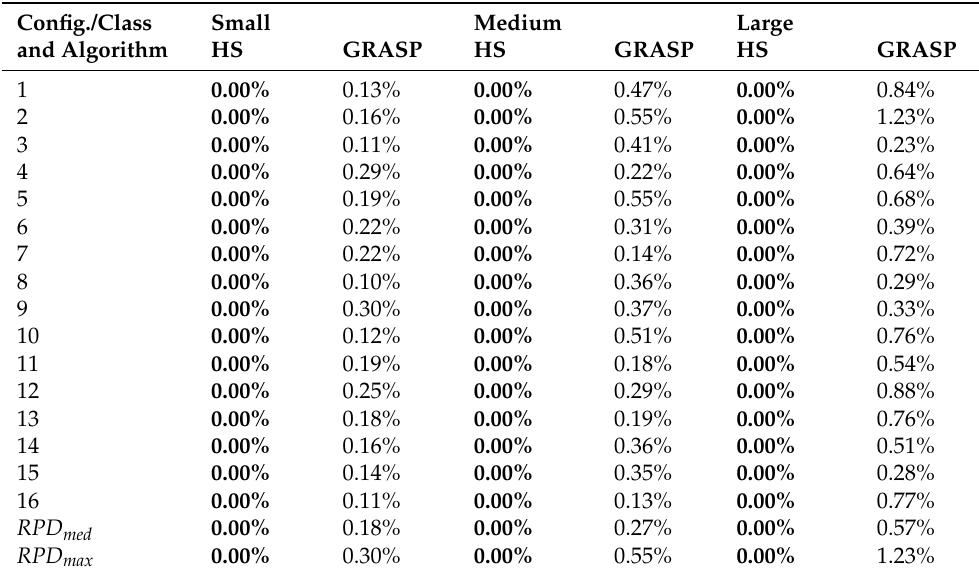
Table 7. Median RPDs and global indicators to compare HS and